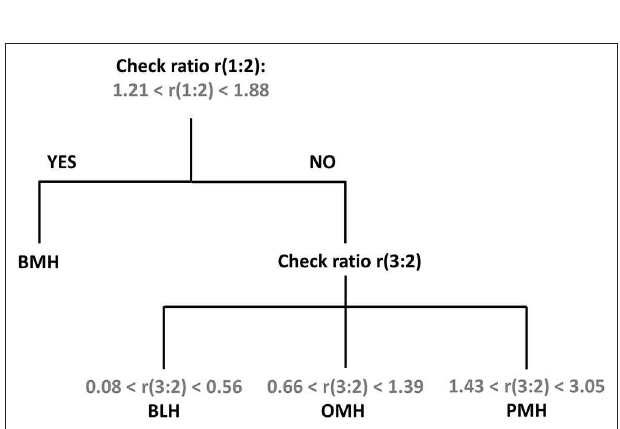
FIGURE 4 | Boxplots of the computed ratios r(1:2) and r(3:2) for the different heparin sources.